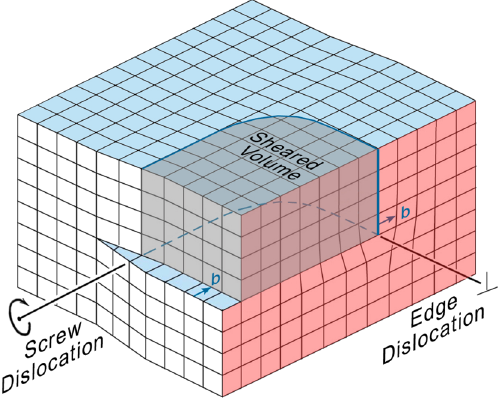
FIG. 3. (Color) Curved dislocations have edge and screw com- ponents.